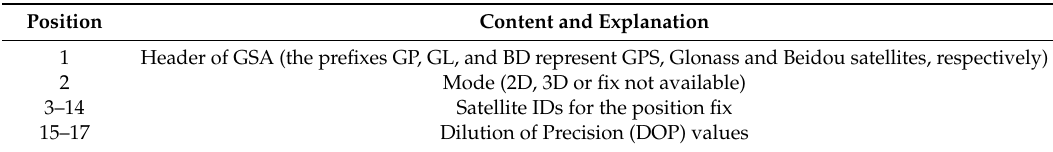
Table 1. GSA sentence